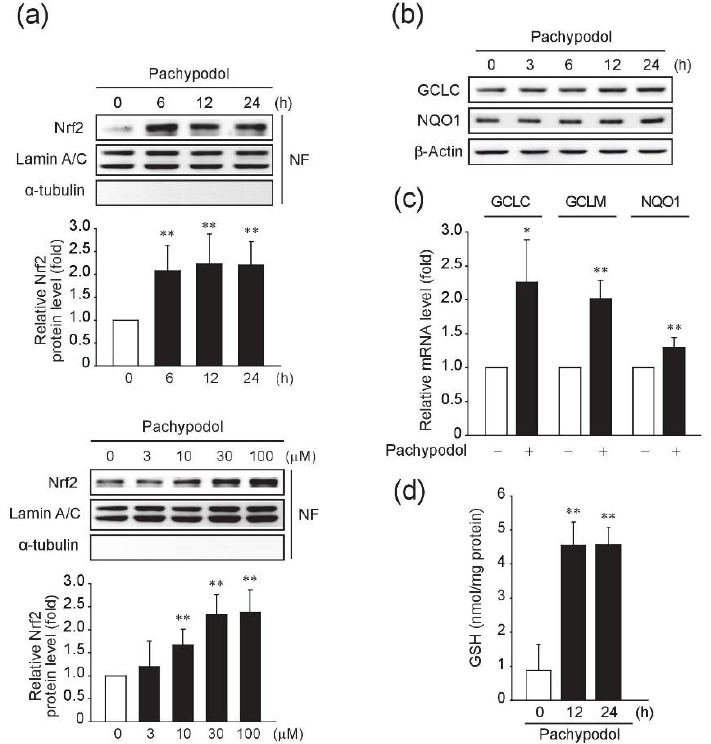
Figure 4. Induction of the intracellular antioxidant system by pachypodol. ( a ) Western blotting was performed to analyze the nuclear Nrf2 protein levels in HepG2 cells exposed to 30 µ M pachypodol for the indicated times (upper) or treated with increasing concentrations of pachypodol for 6 h (lower). Lamin A/C (a nuclear protein) was used as a loading control and the purity of nuclear fraction was verified by immunoblotting for -tubulin (a cytosolic protein). Bands were quantified by